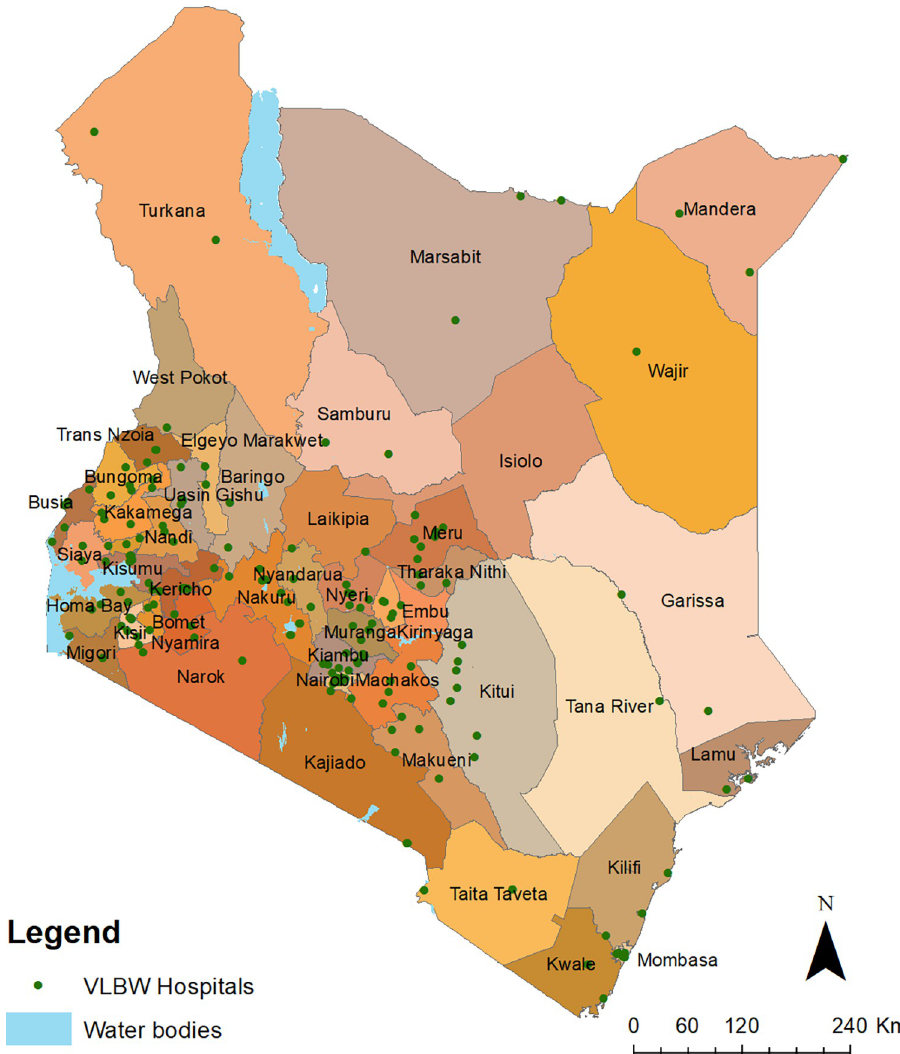
Fig 1. Distribution of 228 VLBW hospitals shown as green dots. The Kenya county shapefiles was obtained from humanitarian data exchange website that is maintained by OCHA